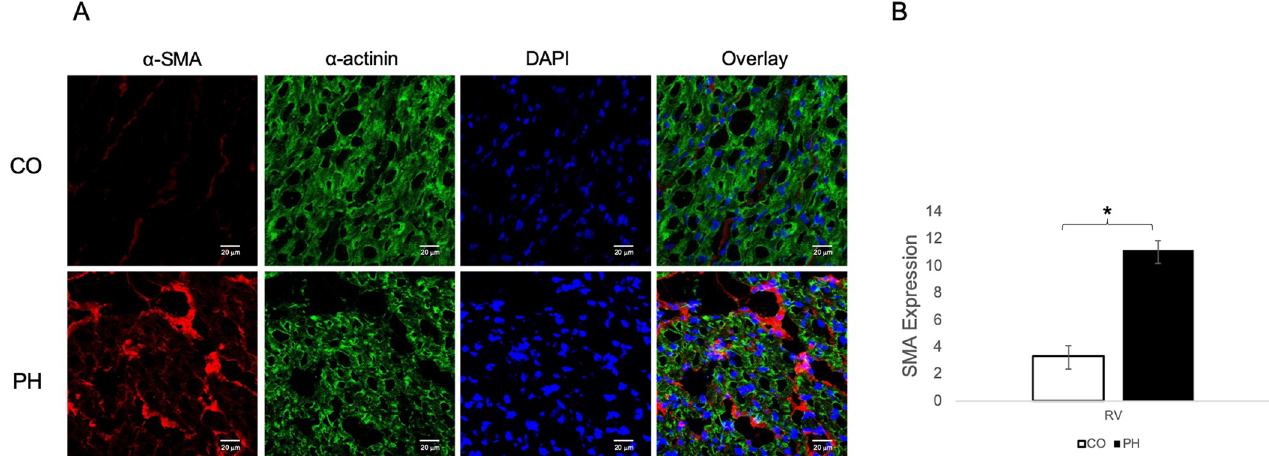
Fig 1. Pulmonary hypertension (PH) induces myocyte disarray in vivo. A) Representative images of mid-RV sections stained for α -SMA (red) and α -actinin (green). RV from control (CO) calves express little α -SMA and are highly organized. However, RV from PH-exposed (PH) calves express higher α -SMA and the normal organized structure of cardiac tissue is disrupted in areas expressing high α -SMA. DAPI (blue) identifies nuclei. Images were taken at 40X, with Zoom at 63X on a Zeiss Laser Scanning Microscope 780. B) Quantification of α -SMA in RV of control and PH-exposed calves (n = 12 CO; n = 12 PH).